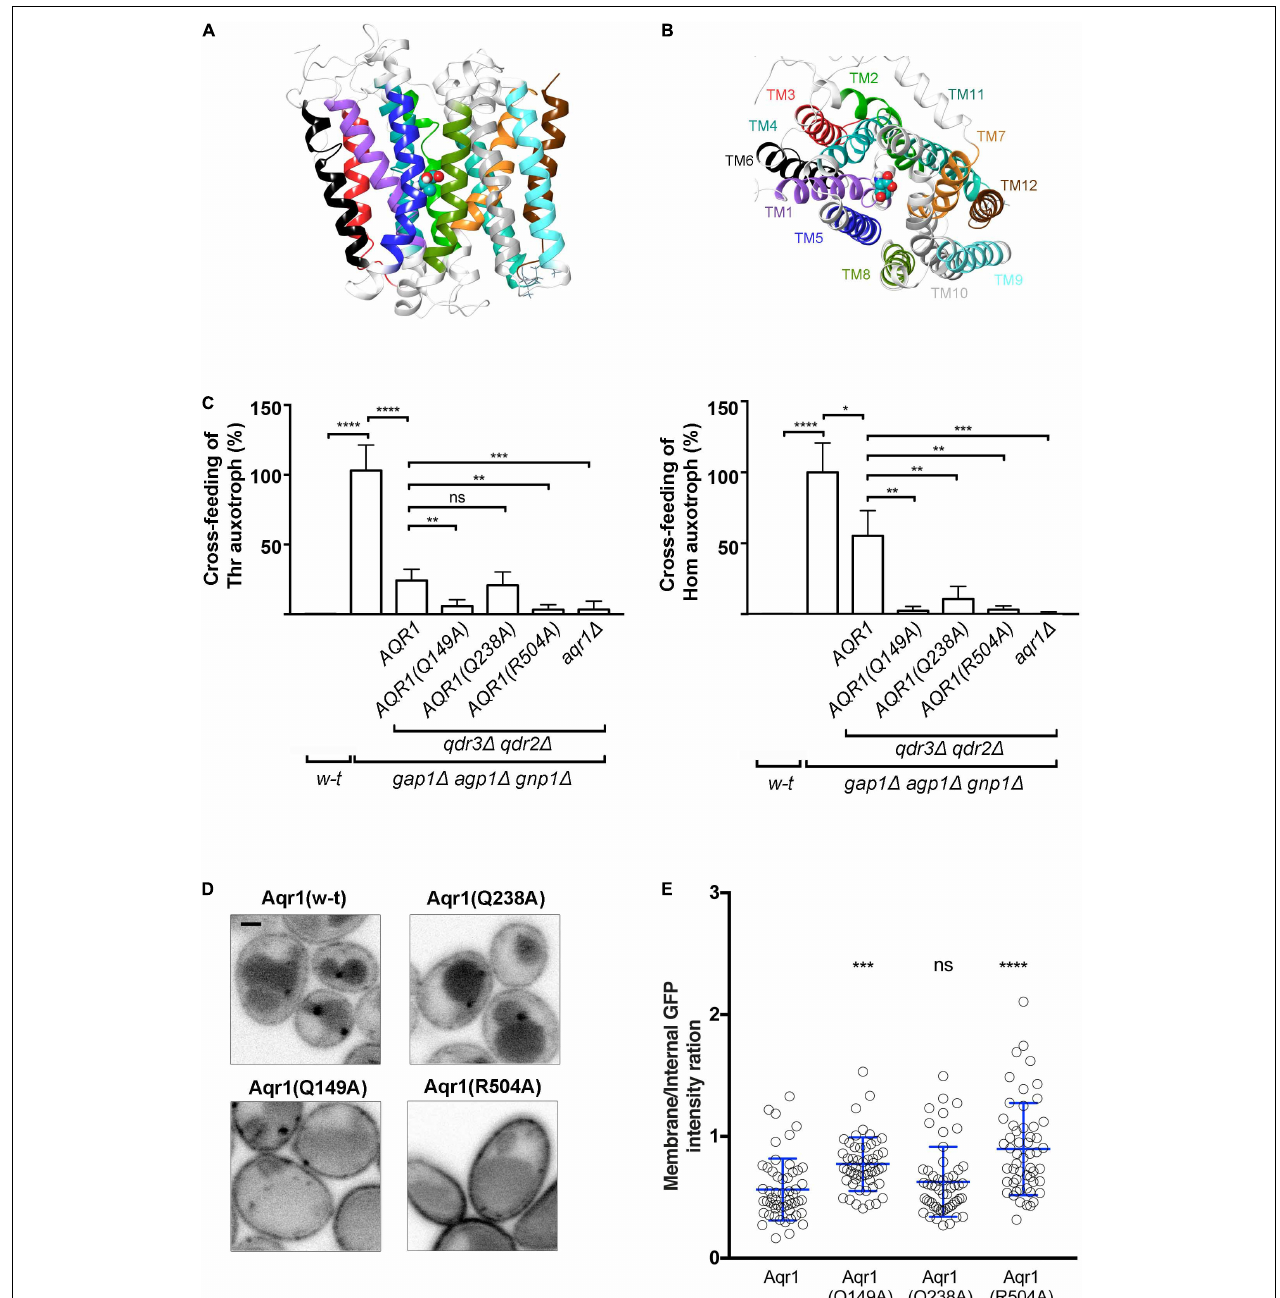
FIGURE 4 | Substitutions in the predicted substrate-binding site of Aqr1 result in loss of Thr and Hom excretion. (A,B) Side (A) and top (B) views of the Aqr1 3D structure modeled using the MdfA 3D structure as template. The protein is depicted as a ribbon diagram with the transmembrane (TM) segments highlighted and color-coded as in Supplementary Figure 5 . Threonine docked in a region delimited by using the chloramphenicol ligand in MdfA is shown as balls and sticks and colored according to the following scheme: Cyan, carbon; red, oxygen; blue, nitrogen; white, hydrogen. (C) The results of cross-feeding experiments illustrated in Supplementary Figure 6 were quantified as indicated in Figure 2B and normalized vs. the gap1 (cid:49) agp1 (cid:49) gnp1 (cid:49) strain expressing functional AQR1 , QDR2, and QDR3 genes. All strains expressed HOM3-R from a plasmid (pGK008). Bars represent averages of three independent experiments ± standard deviation. * indicates a statistically significant difference as determined with the unpaired t- test. * P < 0.0332; ** P < 0.0021; *** P < 0.0002; and **** P < 0.0001. ns, not significant, P > 0.05. (D,E) Subcellular localization of w-t and mutant Aqr1 proteins C-terminally fused to GFP. (D) Each AQR1-GFP gene was expressed at its chromosomal locus under the control of its endogenous promoter. Strains were grown in minimal glucose glutamate medium up to mid-exponential phase and observed by confocal microscopy. Scale bar = 1 µ m. (E) Quantification of the cell-surface vs. intracellular fluorescence intensity ratio ± standard deviation. *indicates a statistically significant difference as determined with the One-way ANOVA statistical test. * P < 0.0332; ** P < 0.0021; *** P < 0.0002; and **** P < 0.0001. ns, not significant, P > 0.05.